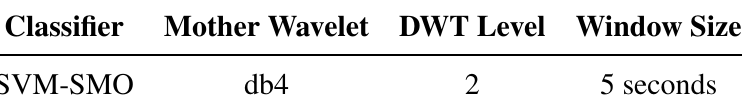
Table 2. Parameter specifications for black-box approach.